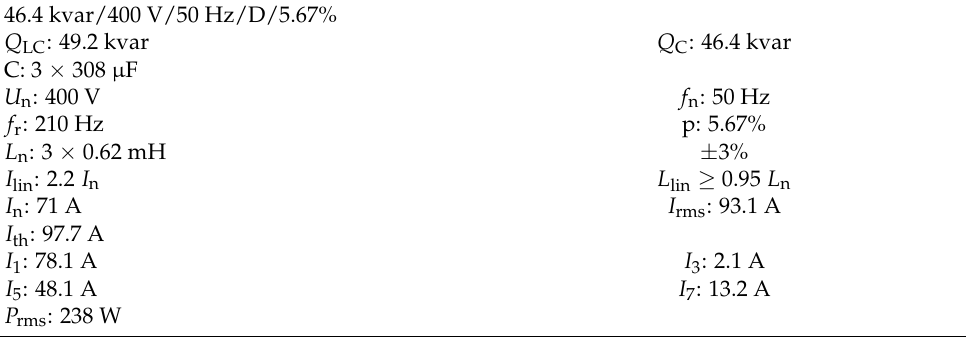
Table A3. Reactor rated data, stages 1 to